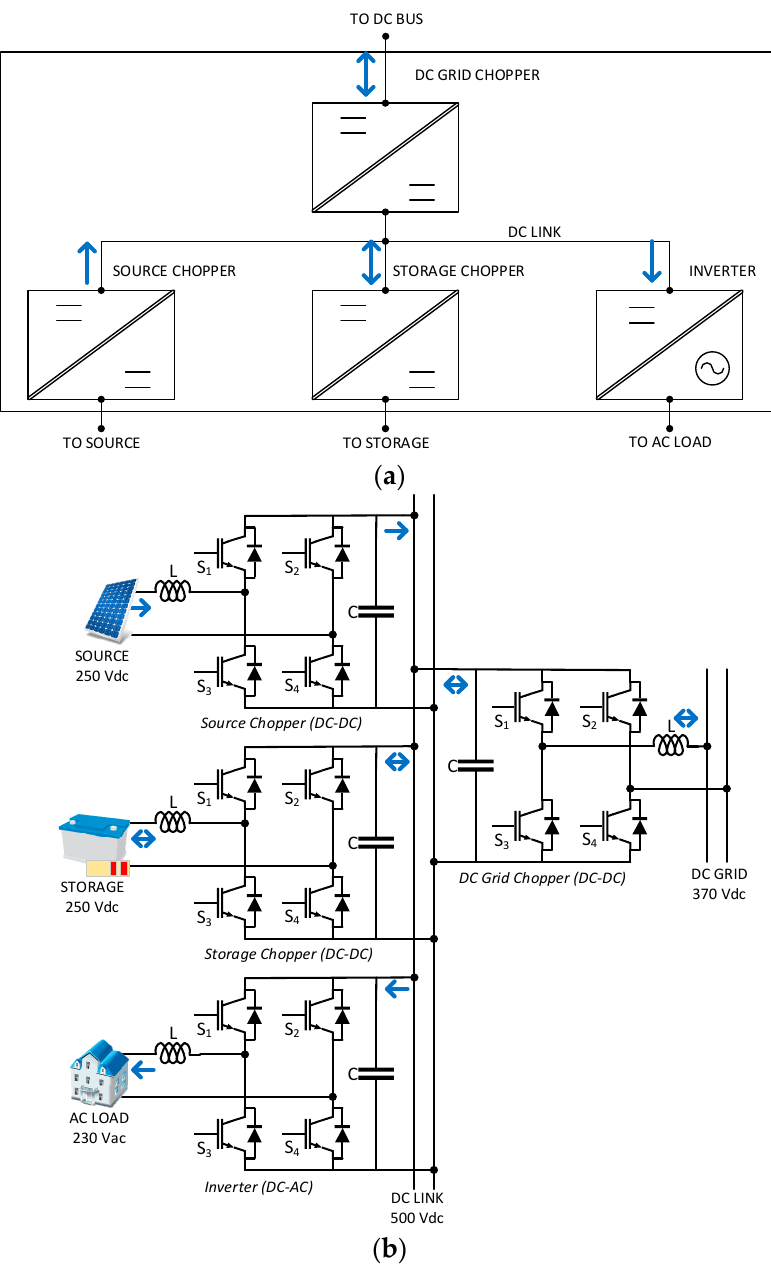
Figure 2. ( a ) Block diagram of a power conditioner system (PCS). ( b ) Converters topology employed in PCS.